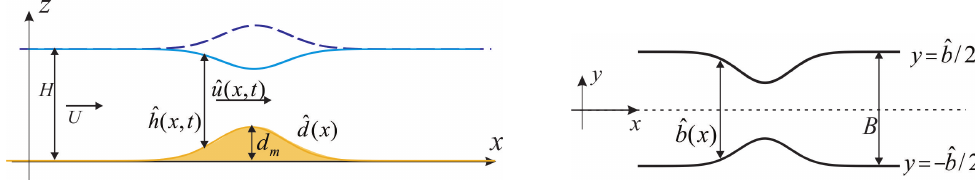
Figure 1. Sketch of the problem and notations; side view ( left ) and top view ( right